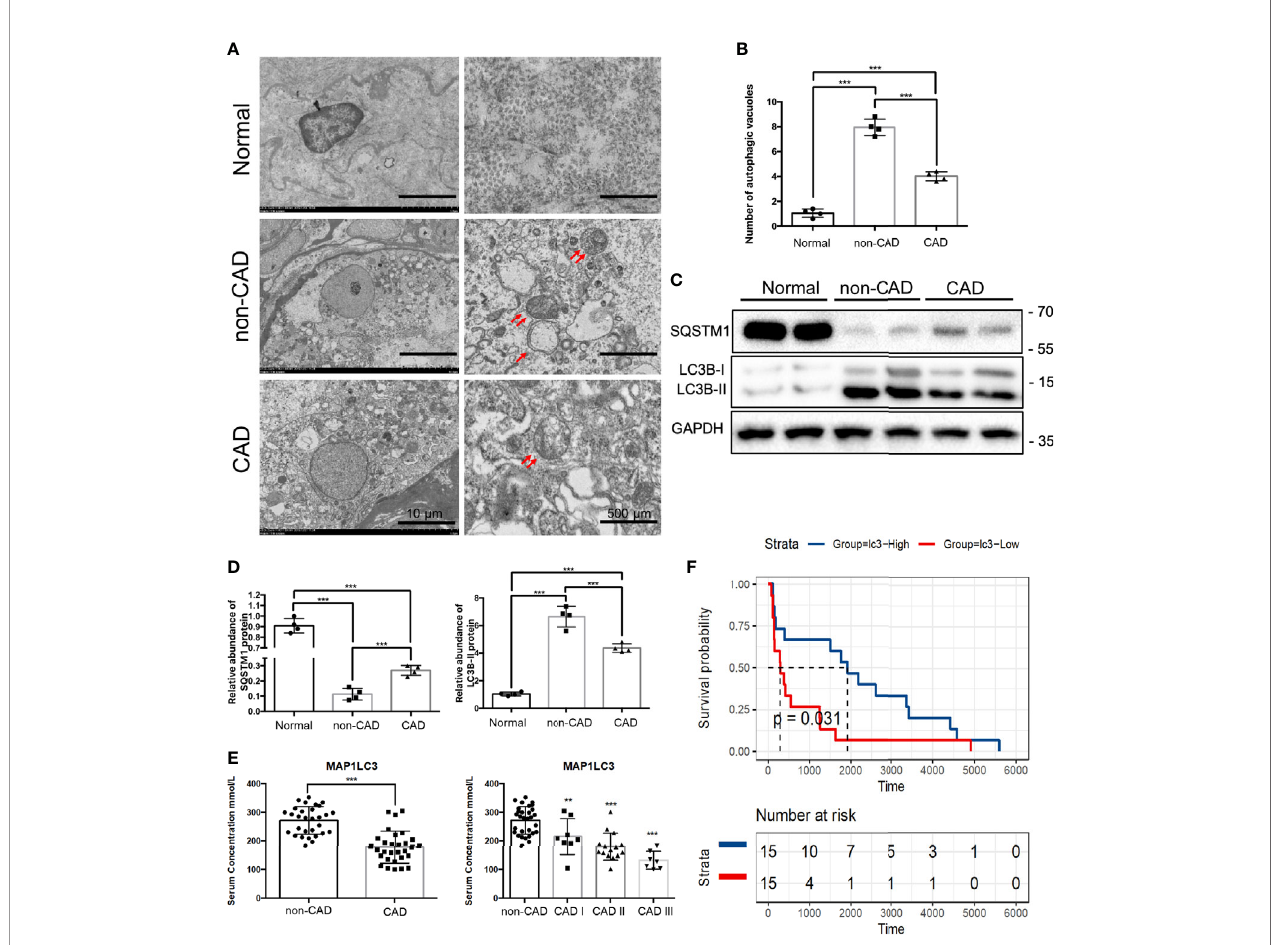
FIGURE 3 | Autophagy, MAP1LC3 expression and prognosis relationship in CAD patients. (A) Representative TEM images of autophagic vacuoles (red double arrow) were shown in glomerulus cells from normal, non-CAD and CAD patients (n=4) (scale bar: 10 m m and 500 m m). (B) Qualitative analysis of the number of autophagic vacuoles from three groups under TEM were shown. (*** P < 0.001, Student t test.) (C) Representative western blot assay results of the protein expressions of SQSTM1 and LC3BI/II in normal, non-CAD and CAD patient kidney tissues were shown. (n=4) (D) Semi-quantitative analysis of Western blot assay results of SQSTM1 and LC3BI/II in normal, non-CAD and CAD patient kidney tissues. (*** P < 0.001, Student t test.) (E) Serum concentrations of MAP1LC3 by ELISA assay in 30 non-CAD patients and 30 CAD patients with different degree. (*** P < 0.001, ** P < 0.01, vs. the non-CAD group, Student t test.) (F) Survival analysis of different MAPLC3 serum concentrations in 30 CAD patients based on data from ELISA assay. ( P < 0.05, Student t